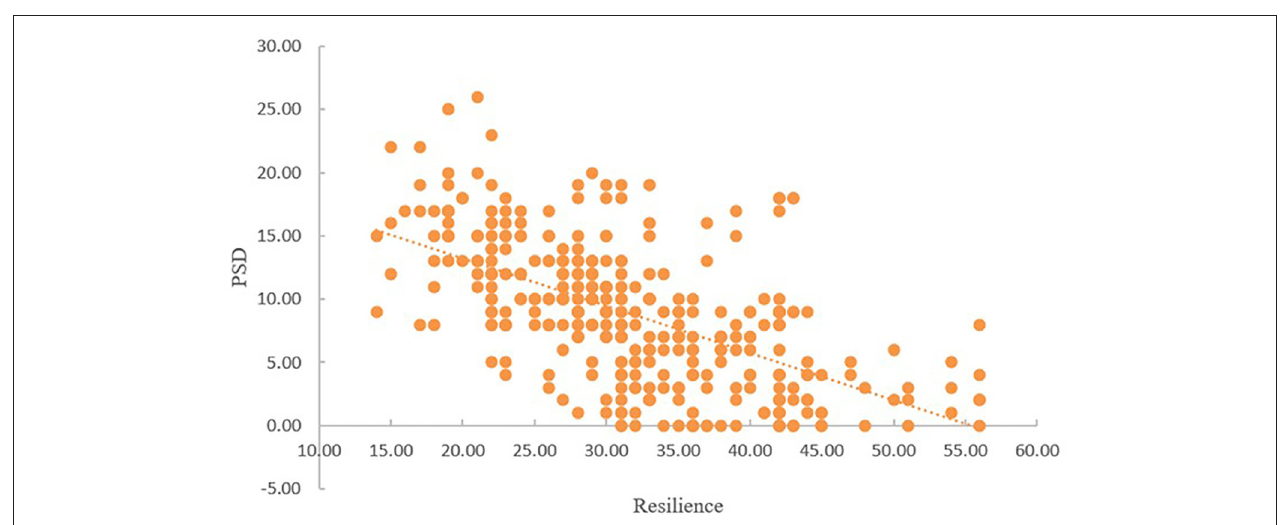
FIGURE 2 | The correlation between resilience and